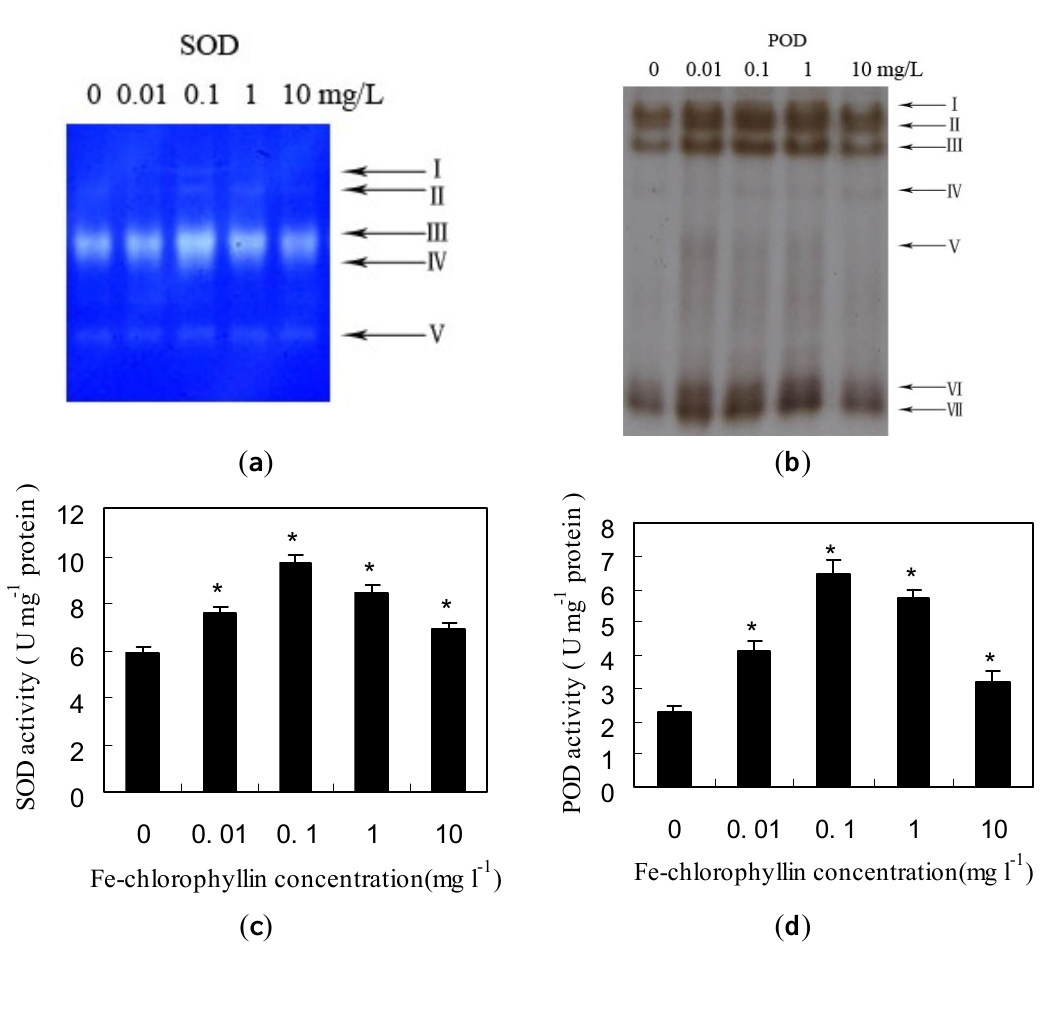
Figure 2. Effects of Fe-chlorophyllin on the activities of SOD and POD in the root of wheat. Seeds of wheat were soaked in the same culture solution containing 0, 0.01, 0.1, 1 and 10 mg/L Fe-chlorophyllin for 12 h and then transferred to the quarter-strength Hoagland’s nutrient solution containing different concentrations of Fe-chlorophyllin for four days after germination. After that, the treated roots homogenized, and root extracts containing 80 μ g proteins were subjected to native polyacrylamide gels electrophoresis. The activities of SOD ( a ) and POD ( b ) were visualized by staining of gels (see Materials and Methods section). The arrows point to bands corresponding to isoforms. In ( c and d ), vertical bars represent standard deviation of the mean ( n = 3). Asterisks indicate that mean values are significantly different between the treatment and control ( p <